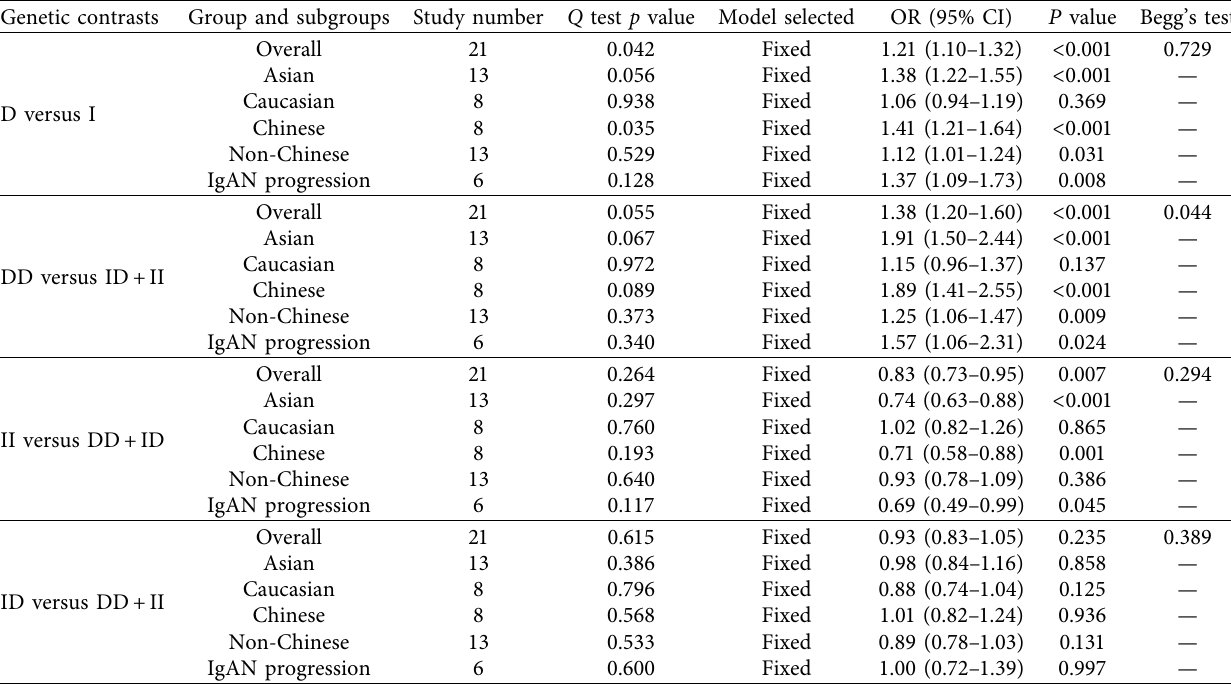
Table 2: Meta-analysis of the link between ACE gene locus I/ D polymorphisms and the susceptibility and progression of IgAN. Genetic contrasts Group and subgroups Study number Q test p value Model selected OR (95%